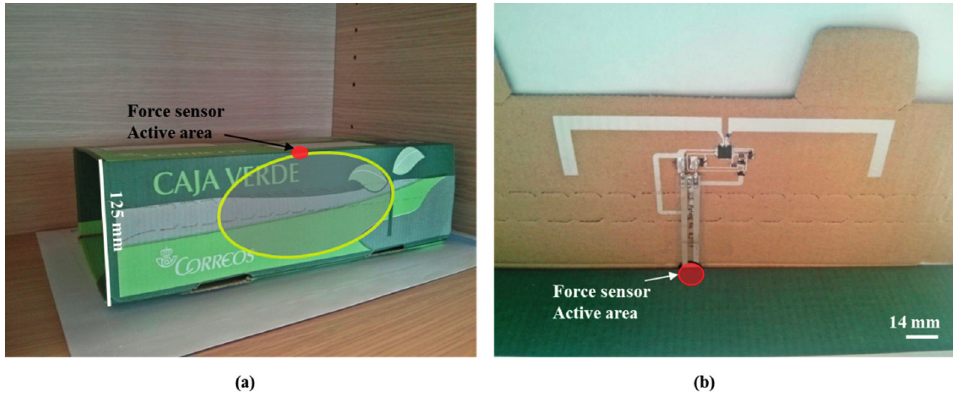
Figure 4. ( a ) Close cardboard with RFID tag; ( b ) view of the RFID tag before closing the